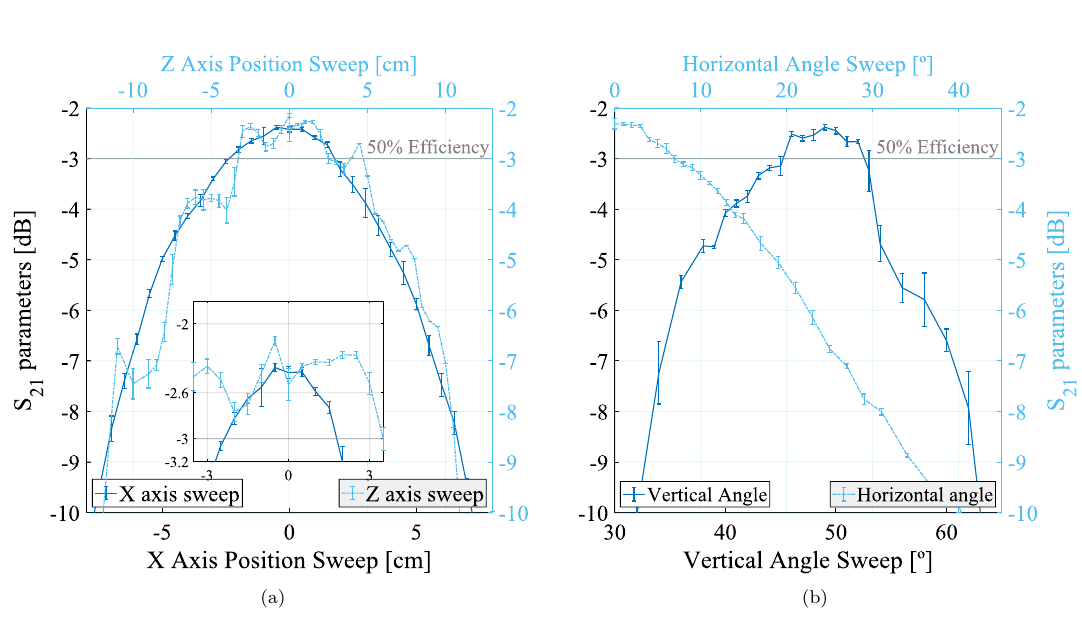
Figure 5. ( a ) Positioning parameters’ influence on the efficiency: transmitting horn antenna’s positioning in ˆ Z the axis and receiving horn antenna’s positioning in the efficiency: transmitting horn antenna’s yaw, θ , and pitch, θ ,